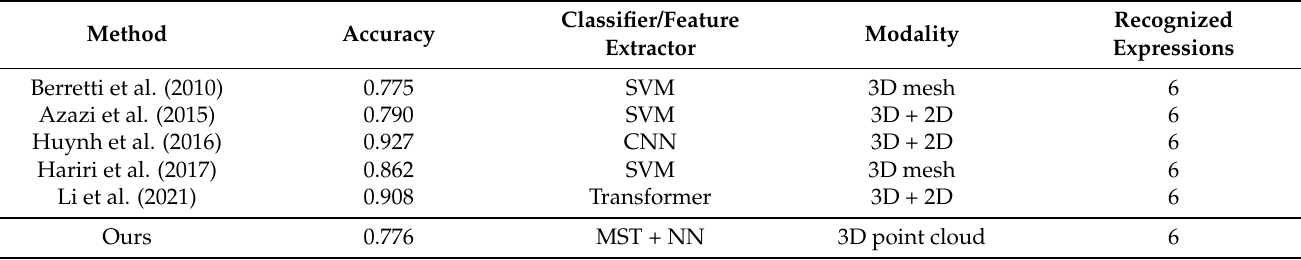
Table 6. Protocol comparison with state-of-art methods on the 3D-BUFE